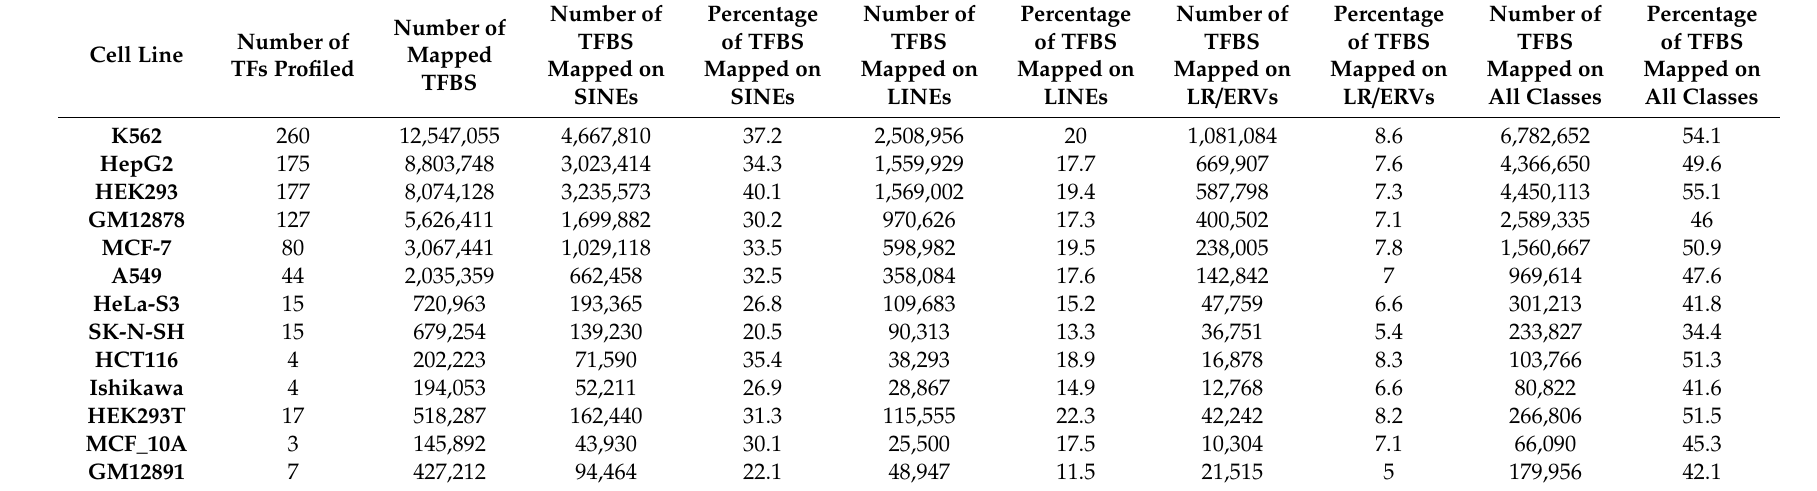
Table 2. Gene neighborhood-linked TFBS